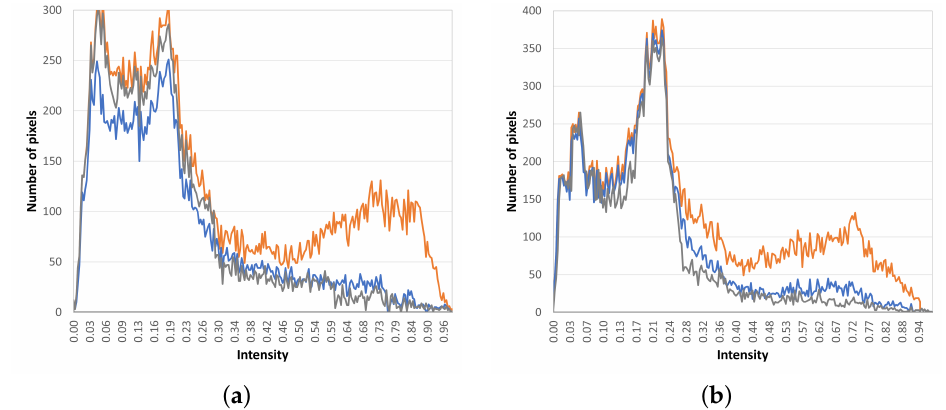
Figure 6. Histograms for the initial map (orange color), after applying the cloud mask according to the conventional SatBaltic algorithm (blue color) and after completing using the method of moments (grey color) for the: ( a ) temperature function (set A.1, Table 3) and ( b ) reflectance function (set A.2, Table 3) (orange—initial map, blue—after applying conventional cloud mask, grey—after completing by moments mask). Table 3. SEVIRI data sets used in further